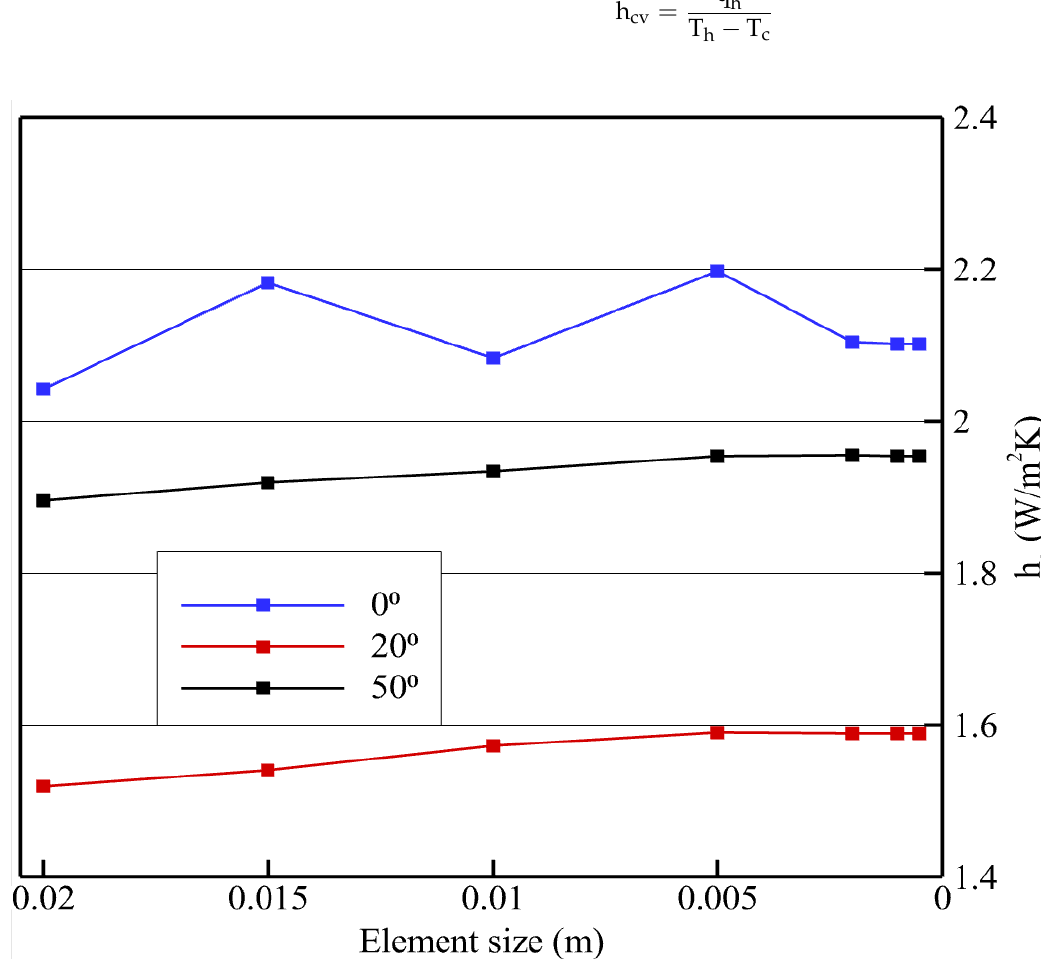
Figure 4. Variation of heat transfer coefficient with element size.